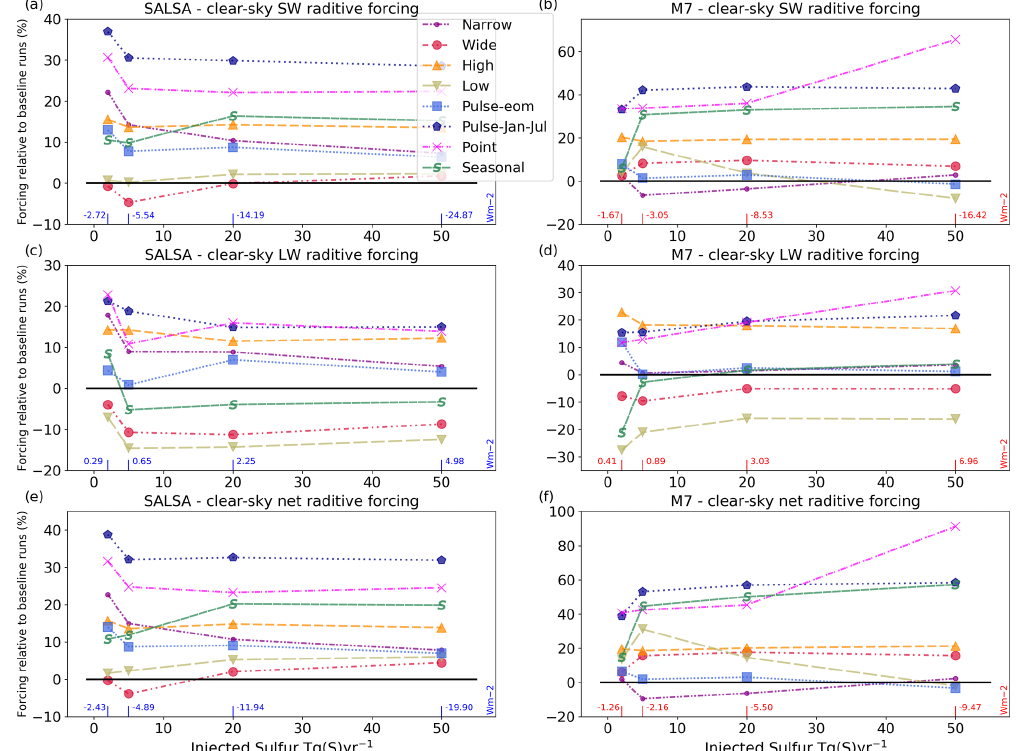
Figure 6. Relative global mean clear-sky SW (a,b) , LW (c,d) and net radiative forcing in sensitivity scenarios compared with the Baseline scenario and its corresponding sulfur injection rate. Baseline values are shown at the bottom of each panel. SALSA results are shown in panels (a) , (c) and (e) , and M7 results are shown in panels (b) , (d) and (f) . Note the different y -axes scales between the